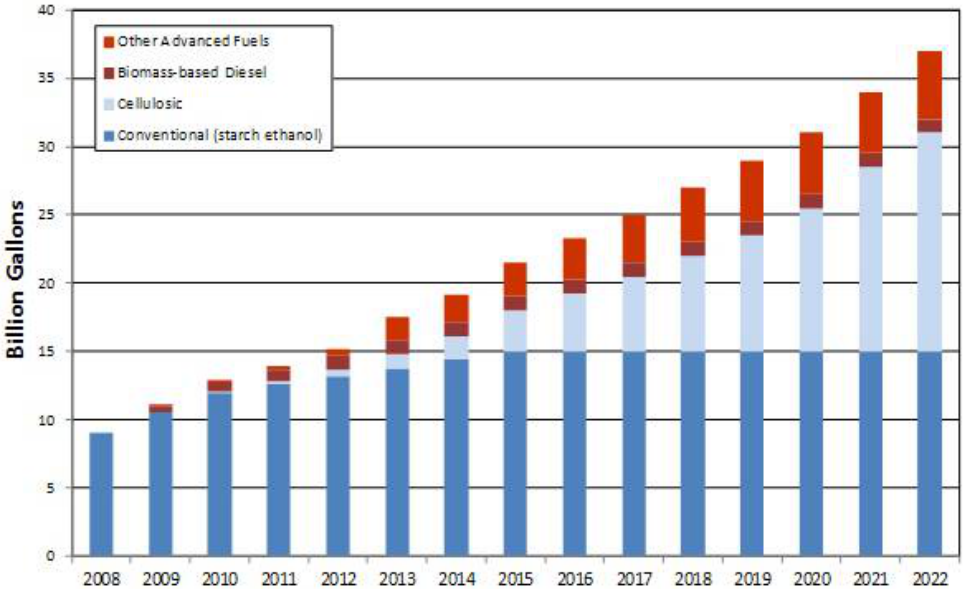
Figure 5. RFS volume requirements set by the EISA [34].